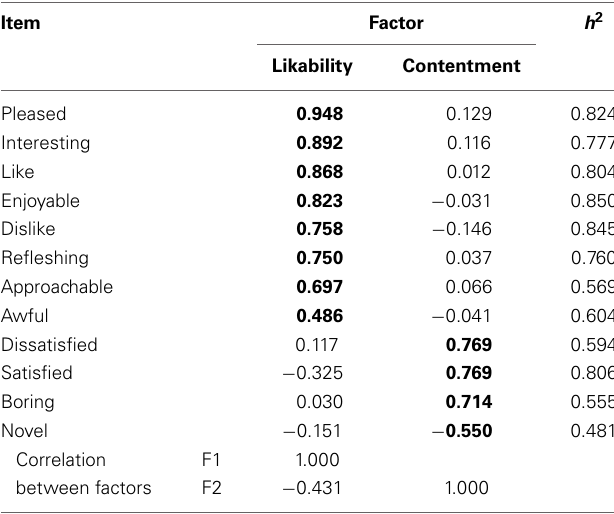
Table 2 | Factor loadings for the items in the museum scale after promax